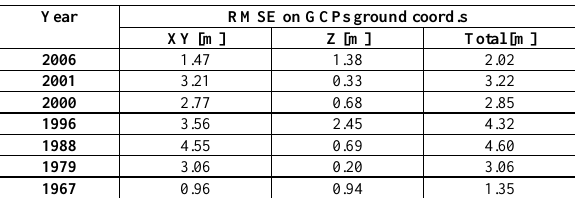
Table 2 . Root Mean Square Errors (RMSE) of